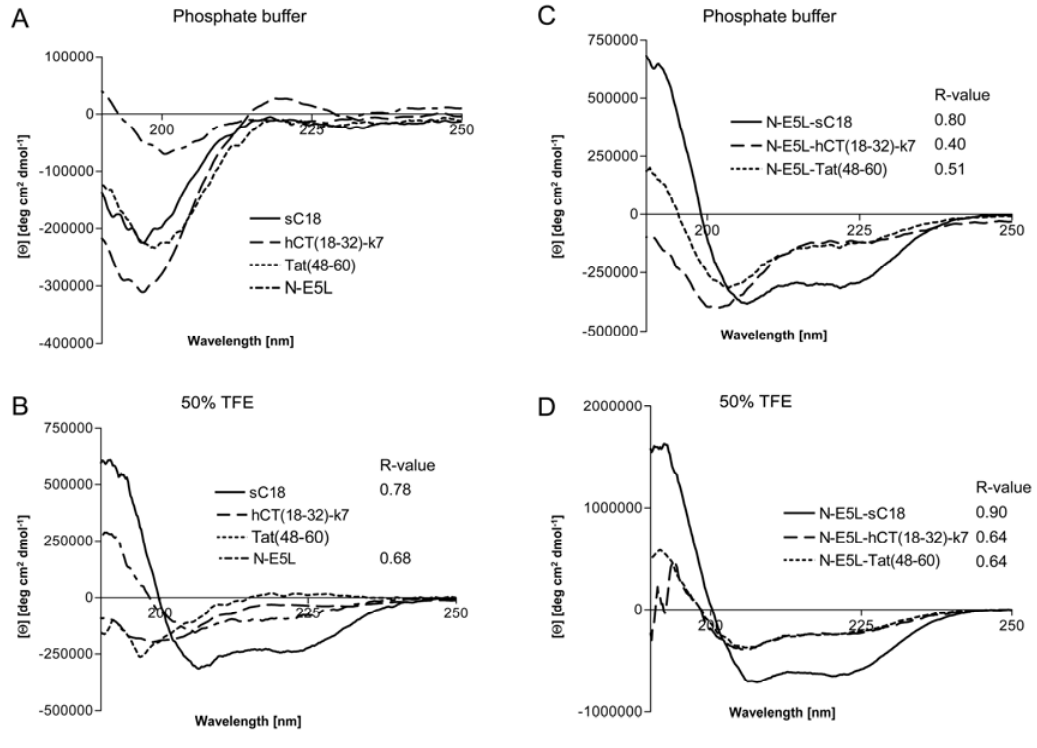
Figure 5. Circular dichroism spectra of the investigated peptides. The spectra were measured at a peptide concentration of 20 µM in 10 mM phosphate buffer [(a), (c)] and 10 mM phosphate buffer with the addition of 50% TFE [(b), (d)]. R-values represent the ratios between the molar ellipticity values at 222 nm and 207